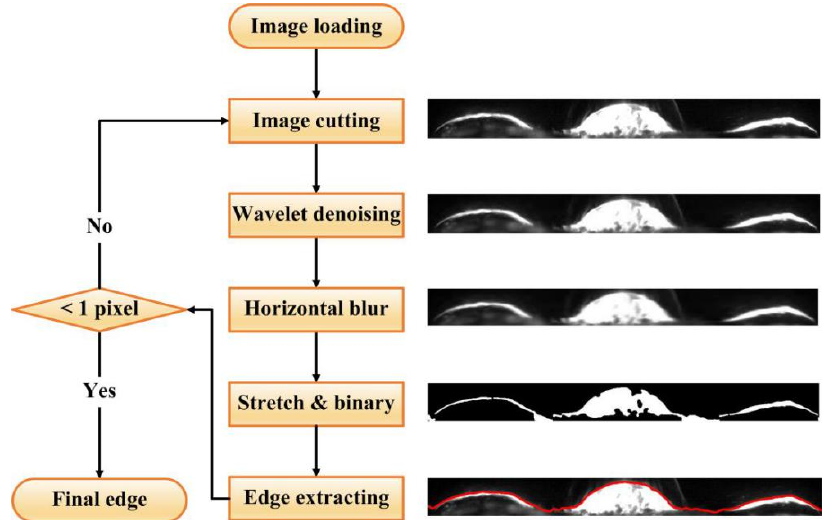
Figure 2. Post-processing steps of extracting the upper edge of the liquid film.